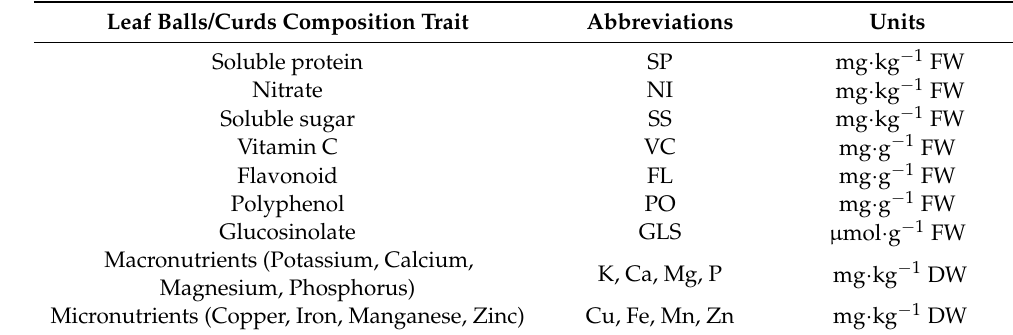
Table 3. Compositional characteristics, abbreviations used, and expression units for cabbage, cauliflower, and Chinese cabbage varieties considered in this